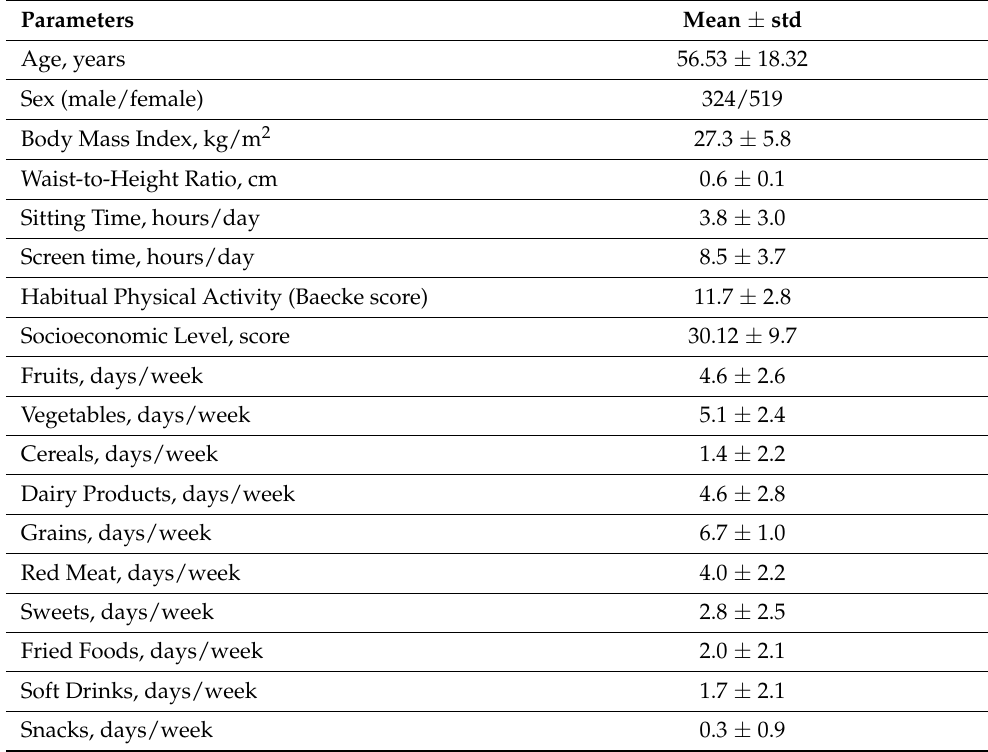
Table 1. Descriptive characteristics of the